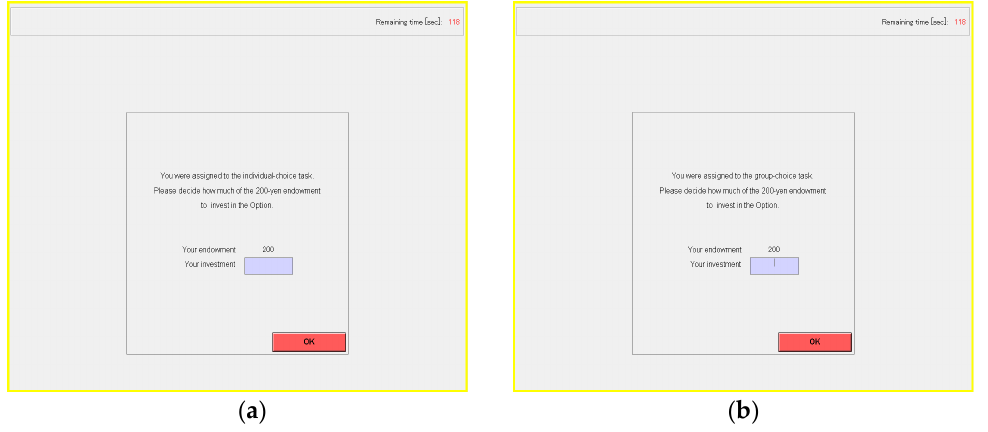
Figure A4. Computer screen for Task 3: ( a ) For the individual-choice task; ( b ) For the group-choice task.